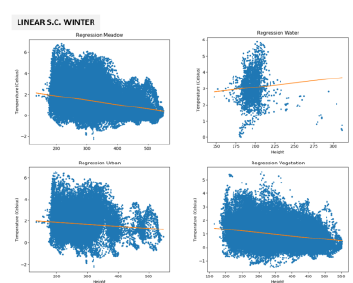
Figure 20: Polynomial Regression Model in